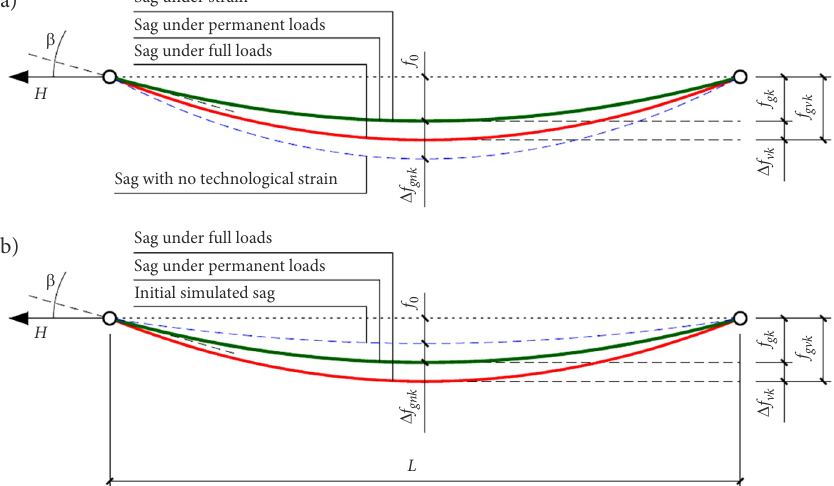
Figure 3. Displacements of symmetrically loaded cable: a) applying technological strain; b) without technological